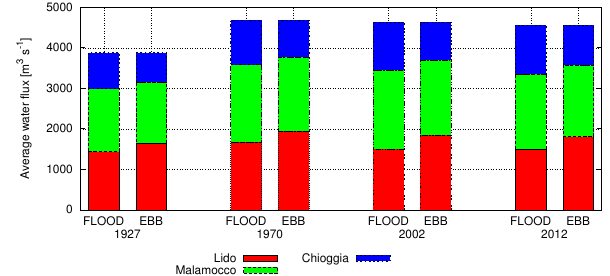
Fig. 3. Average water fluxes between the lagoon and the sea during ebb and flood tide for the four past and present situations (1927, 1970, 2002,